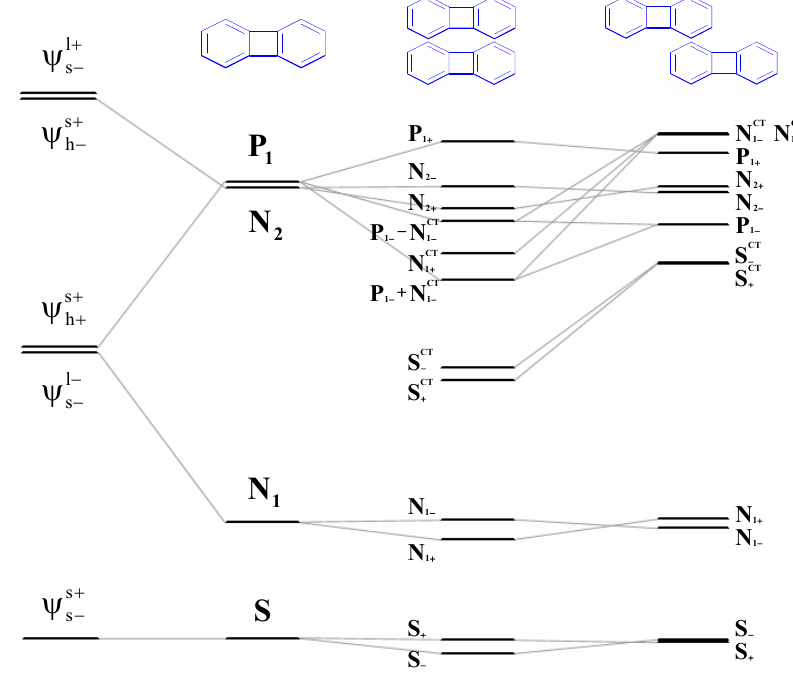
Figure 10. State correlation diagrams of biphenylene, H-aggregrated biphenylene dimer (d = 4 Å), and J-aggregrated biphenylene dimer (d = 4 Å). [51]. Reproduced with permission from American Chemical